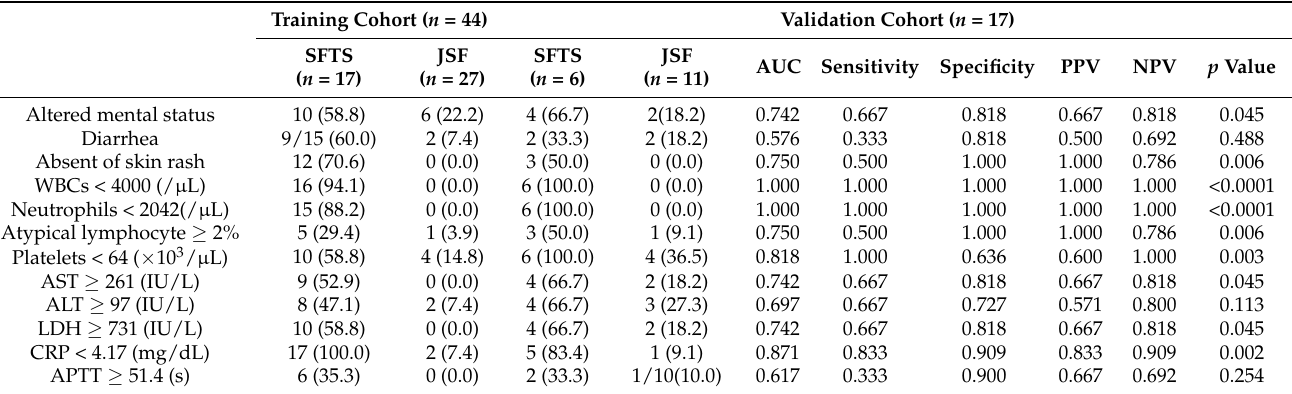
Table 5. Sensitivity, specificity, positive predictive value and negative predictive value for differenti- ating SFTS from